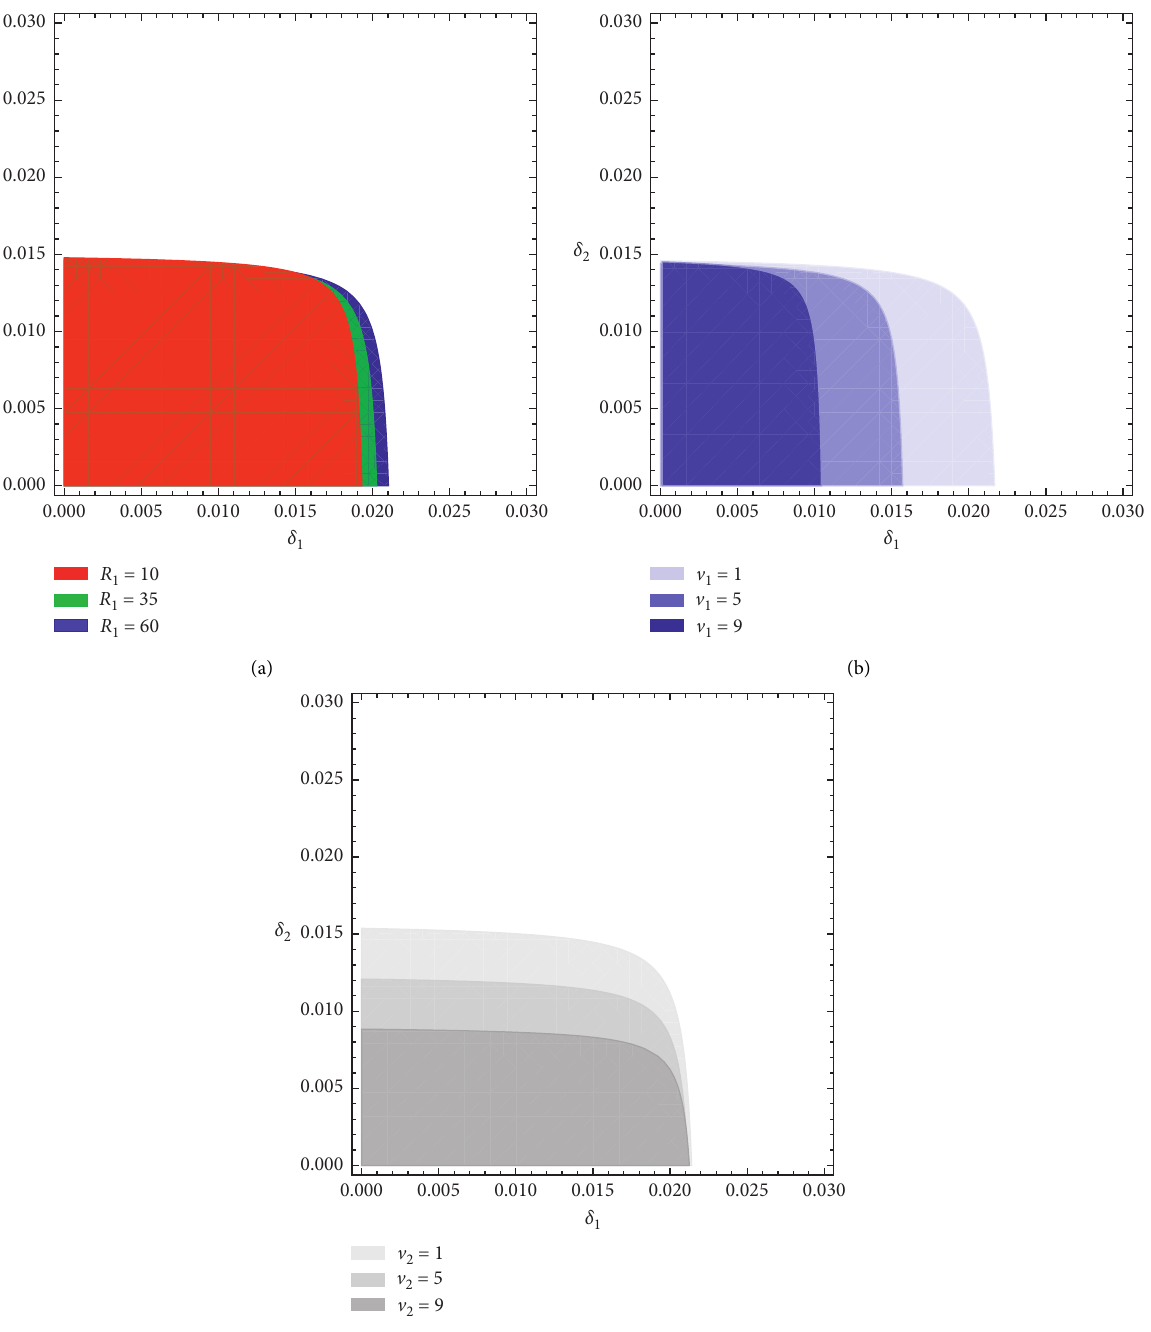
, v , and v having different values. (a) R 1 1 2